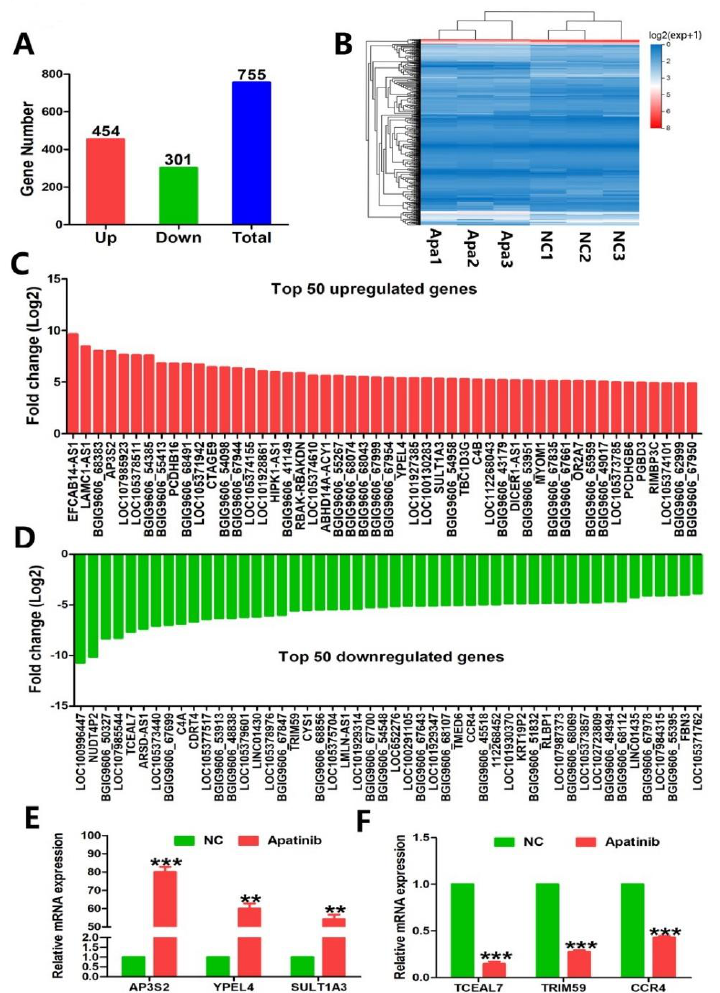
Figure 2. Transcriptional profiles of apatinib − treated RKO cells. ( A ) The number of genes upregu- lated and downregulated by apatinib. ( B ) Heatmap of differentially expressed genes between the normal group and CRC group. ( C , D ) Bar graphs showing the top 50 upregulated genes and top 50 downregulated genes in apatinib-treated RKO cells. ( E ) RKO cells were treated with apatinib at 20 µ M for 48 h, and the mRNA expression of upregulated genes AP3S2, YPEL4 , and